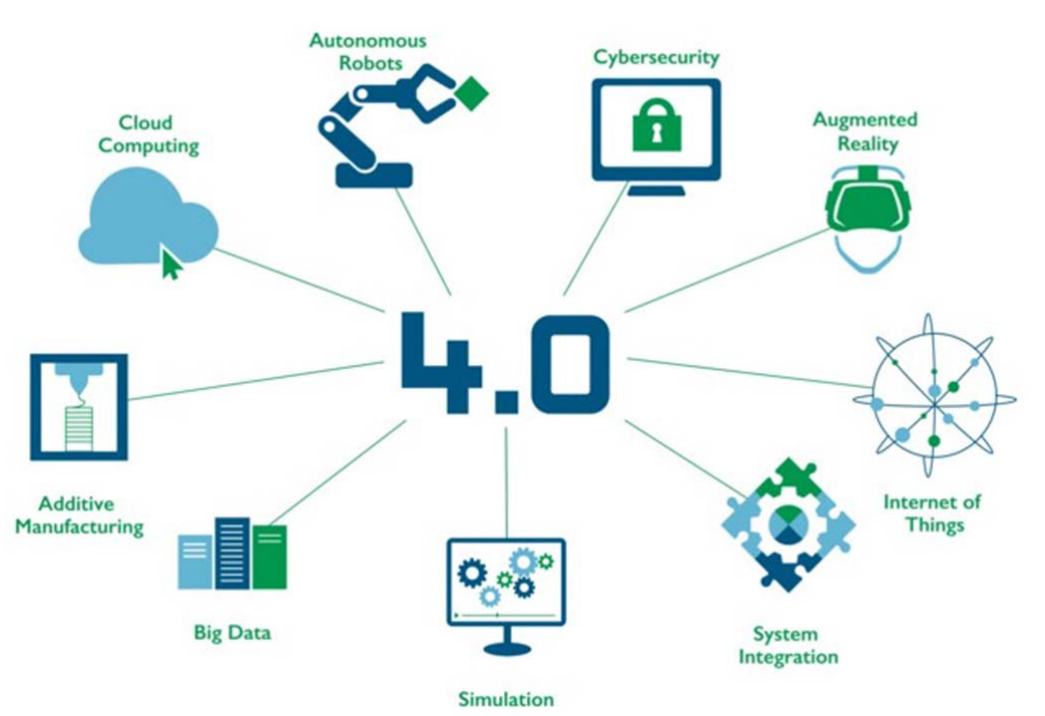
Figure 2. A visual representation of all of the improvements and features Industry 4.0 brought